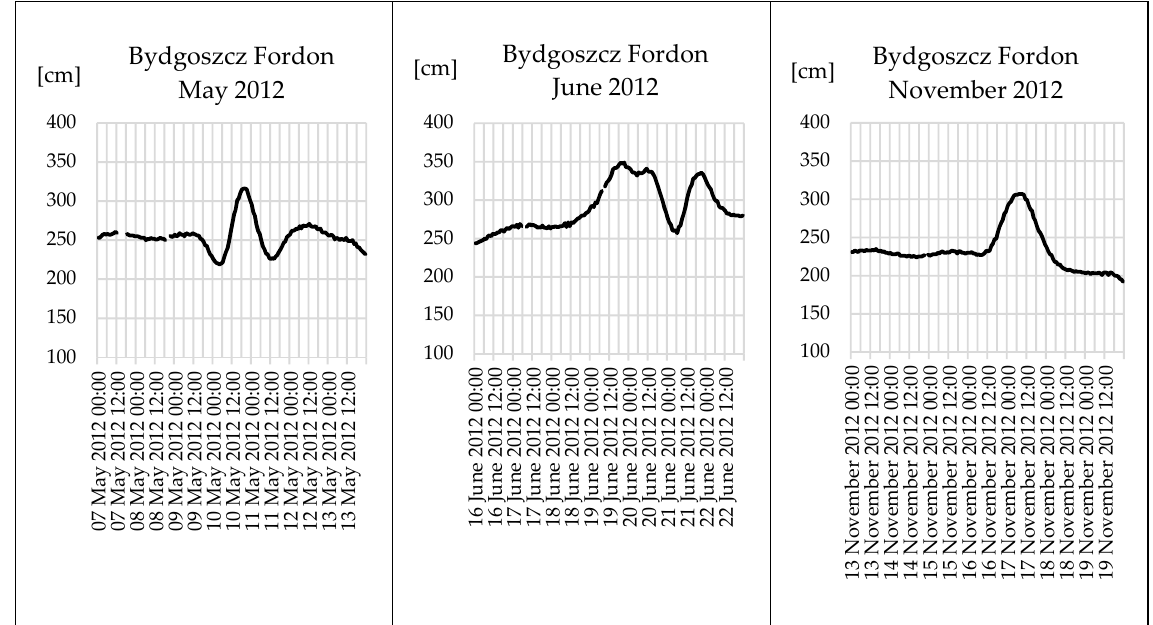
Figure 8. Water levels at the Bydgoszcz Fordon water gauge during emergency discharge from the dam in Włocławek. Own elaboration Source: www.pogodynka.pl.